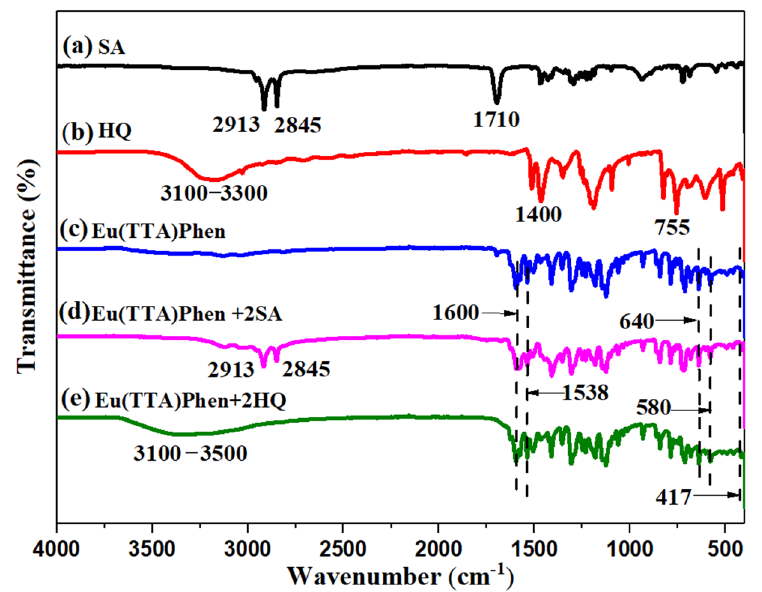
Figure 4. FT-IR spectra: ( a ) SA, ( b ) HQ, ( c ) ETPC, ( d ) ETPC-SA, and ( e ) ETPC-HQ.